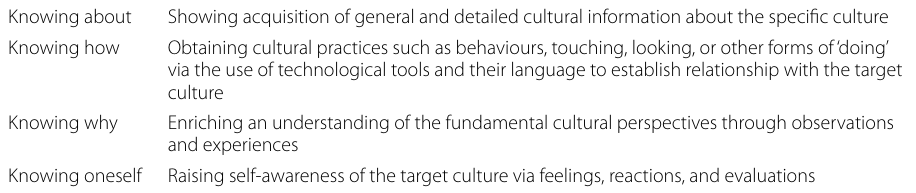
Table 1 Moran’s cultural experience Knowing about Knowing